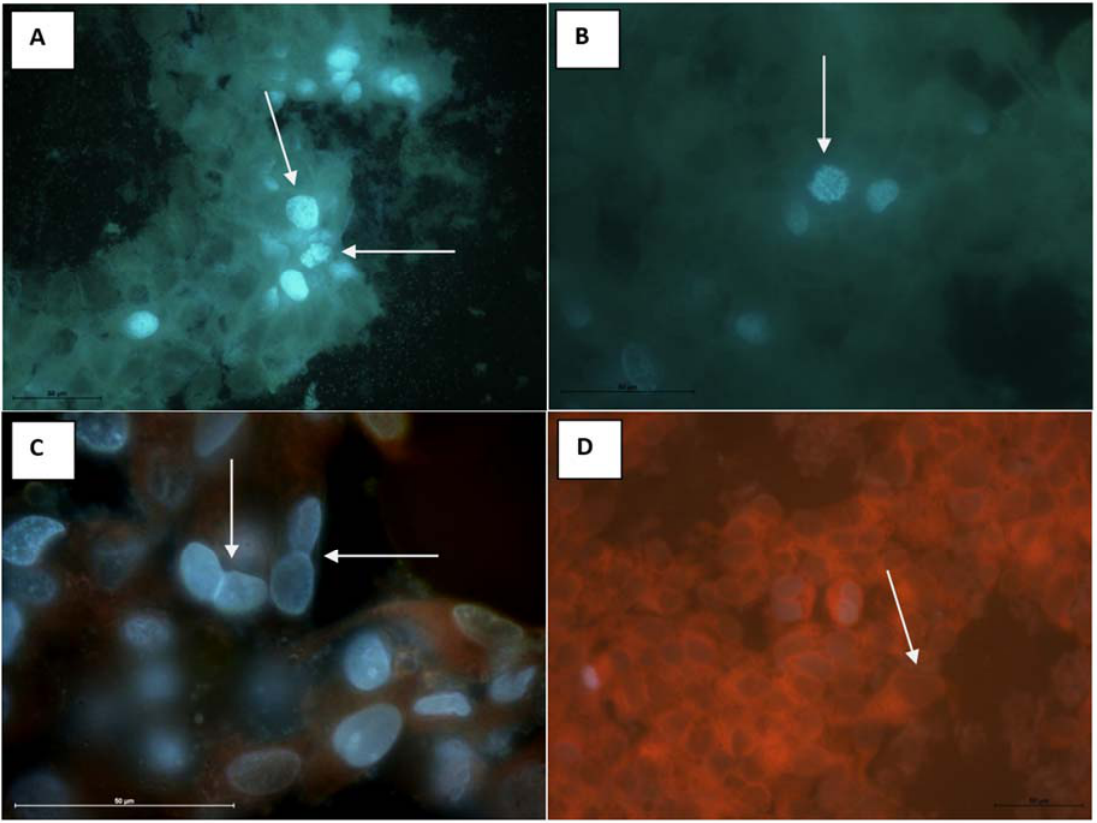
Figure 6. Numerous dividing cell (arrow) in control group, DAPI, 600 × magnification, scale bar = 50 µ m ( A , B ). Inhibited cytokinesis in experimental group (MCF-7), concentration EE is 50 µ g/mL ( C ). Visible cells containing two nuclei (arrow) surrounded by cytoplasm containing cytoskeleton (red) Hoechst and Rhodamine Mag × 1000, scale bar represent = 50 µ m. Inhibited cytokinesis in Cy 3-gluc group concentration 25 µ g/mL ( D ). Inhibited cytokonesis. In all cells two or more nuclei are noted (arrow) Rhodamine B, Mag ×